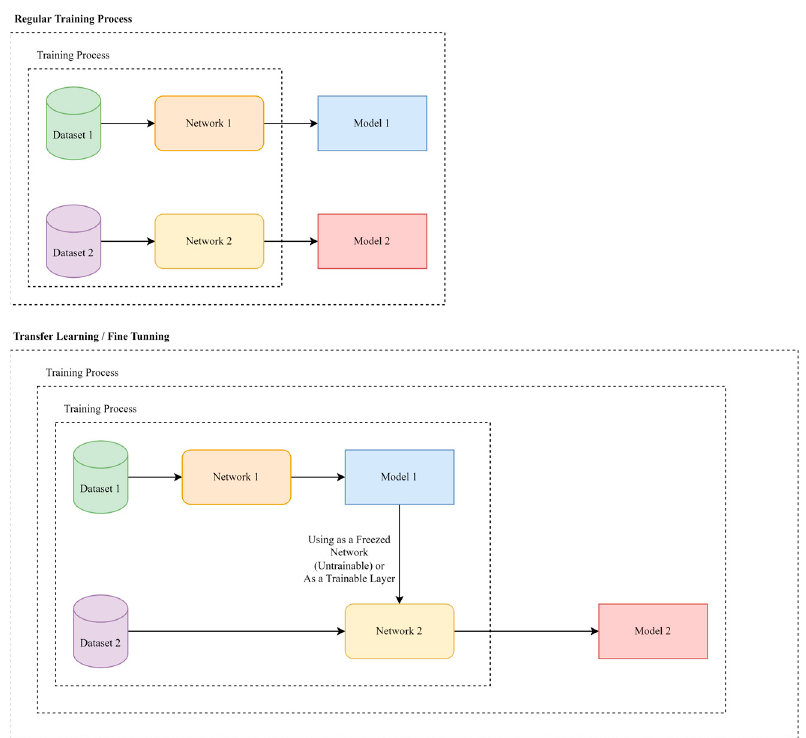
Figure 3. General concept of transfer learning/fine-tuning, based on using pretrained models in the training process of a secondary model.